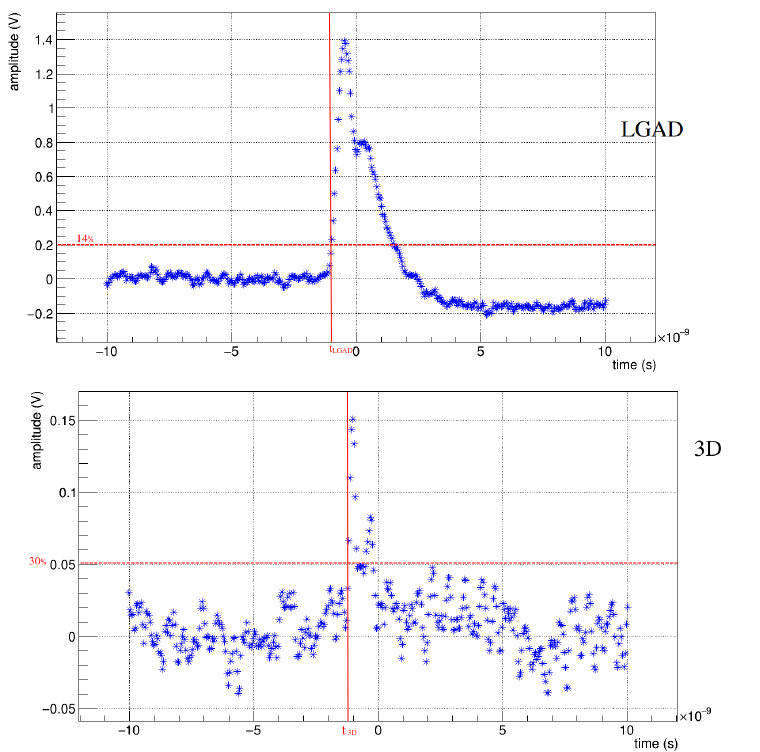
Figure 4. An example of the waveform from an LGAD (B) and 3D detector (B). The red lines indicate the CFD threshold value and corresponding timestamp on the signal.